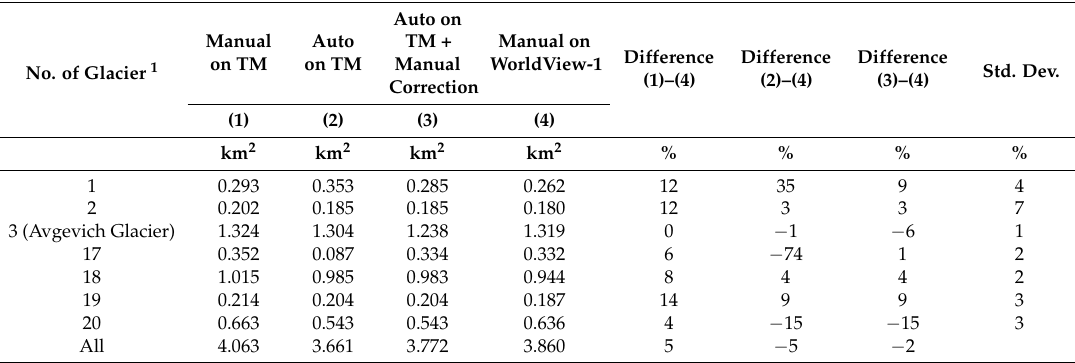
Table 3. Comparison of debris-free glacier areas derived both automatically and manually from TM (on 11 September 2010) and high-resolution WorldView-1 image (on 7 August 2008). Standard deviation was calculated for ten manual digitizations on